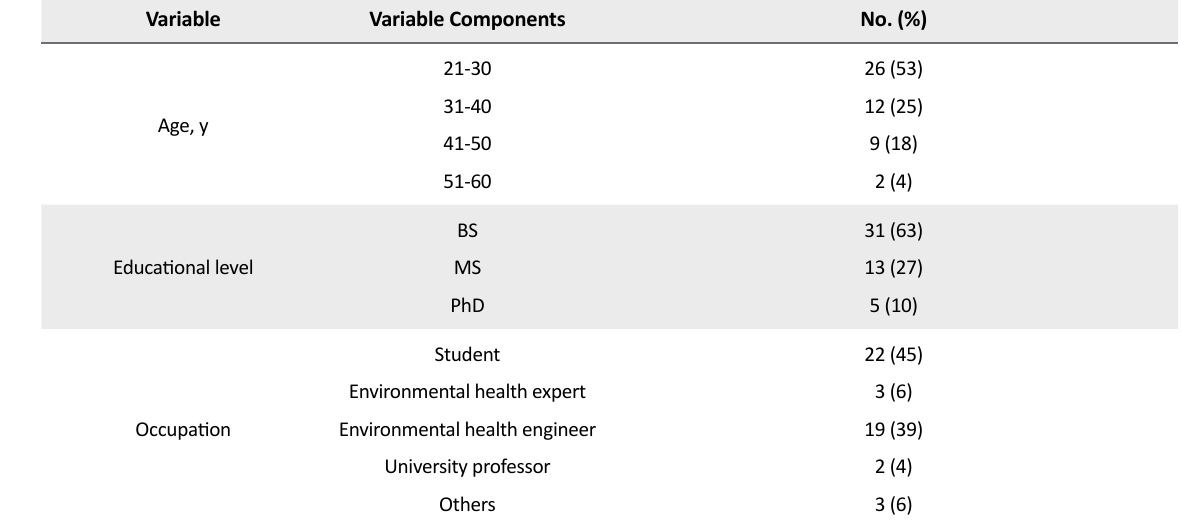
Table 1. Sociodemographic characteristics of respondents (n = 49)